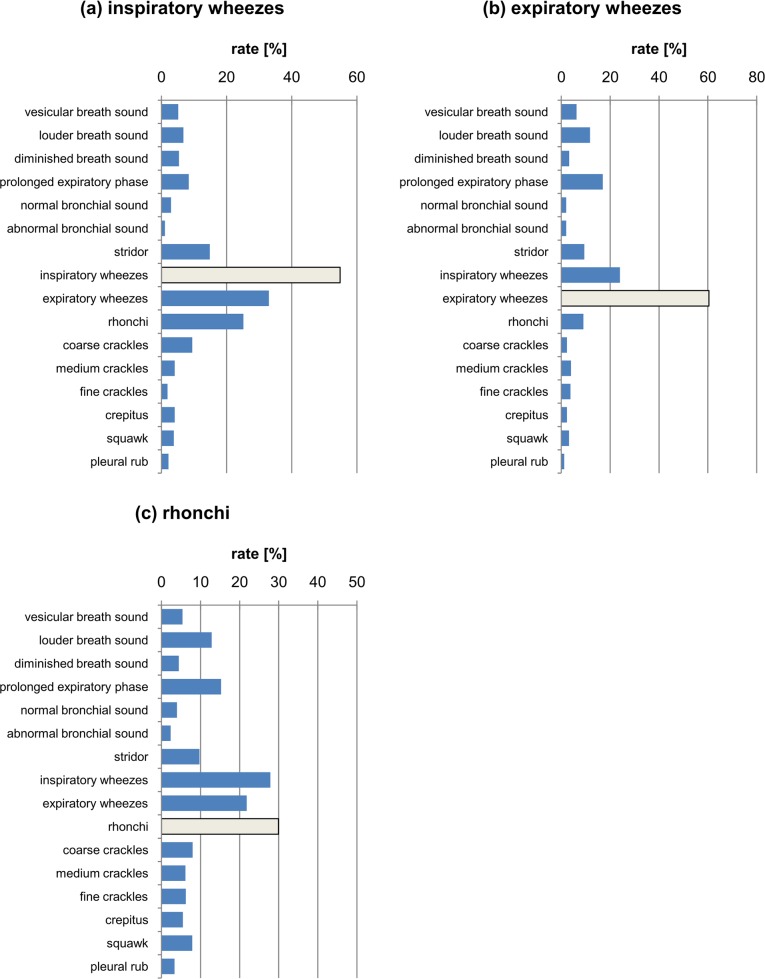
The percentage distribution of responses marked for (a) inspiratory wheezes, (b) expiratory wheezes, (c) rhonchi class. The light grey bar depicts the correct answer.